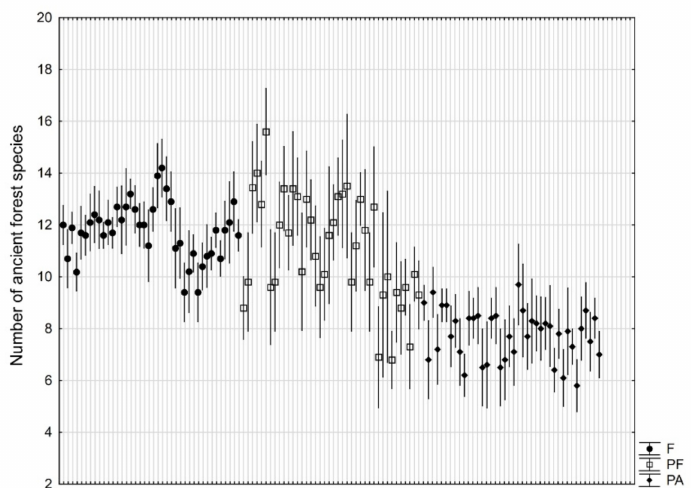
Figure 3. Number (mean ± 95% confidence interval based on 10 research plots of 100 m 2 ) of ancient forest species in natural forests (F), manor parks adjacent to forests (PF), and manor parks not adjacent to forests